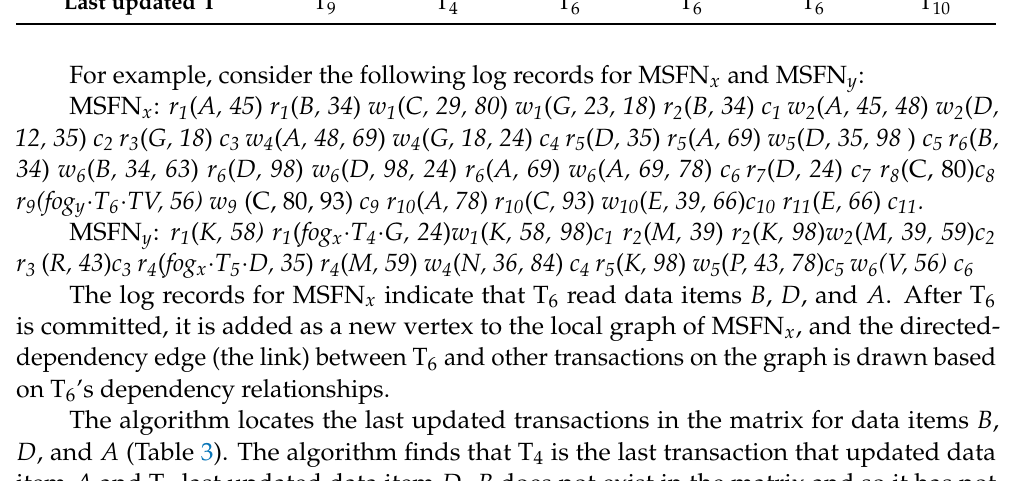
Table 4. Matrix tracking the last updated transactions after T 10 is committed. Data Items C G A D B E Last updated T T